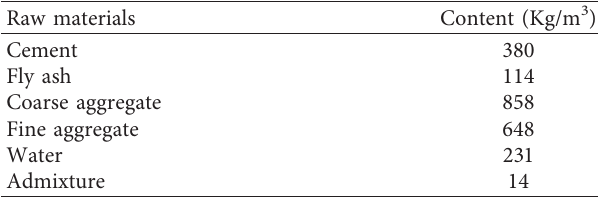
Table 8: Ratio of raw materials of CGB.